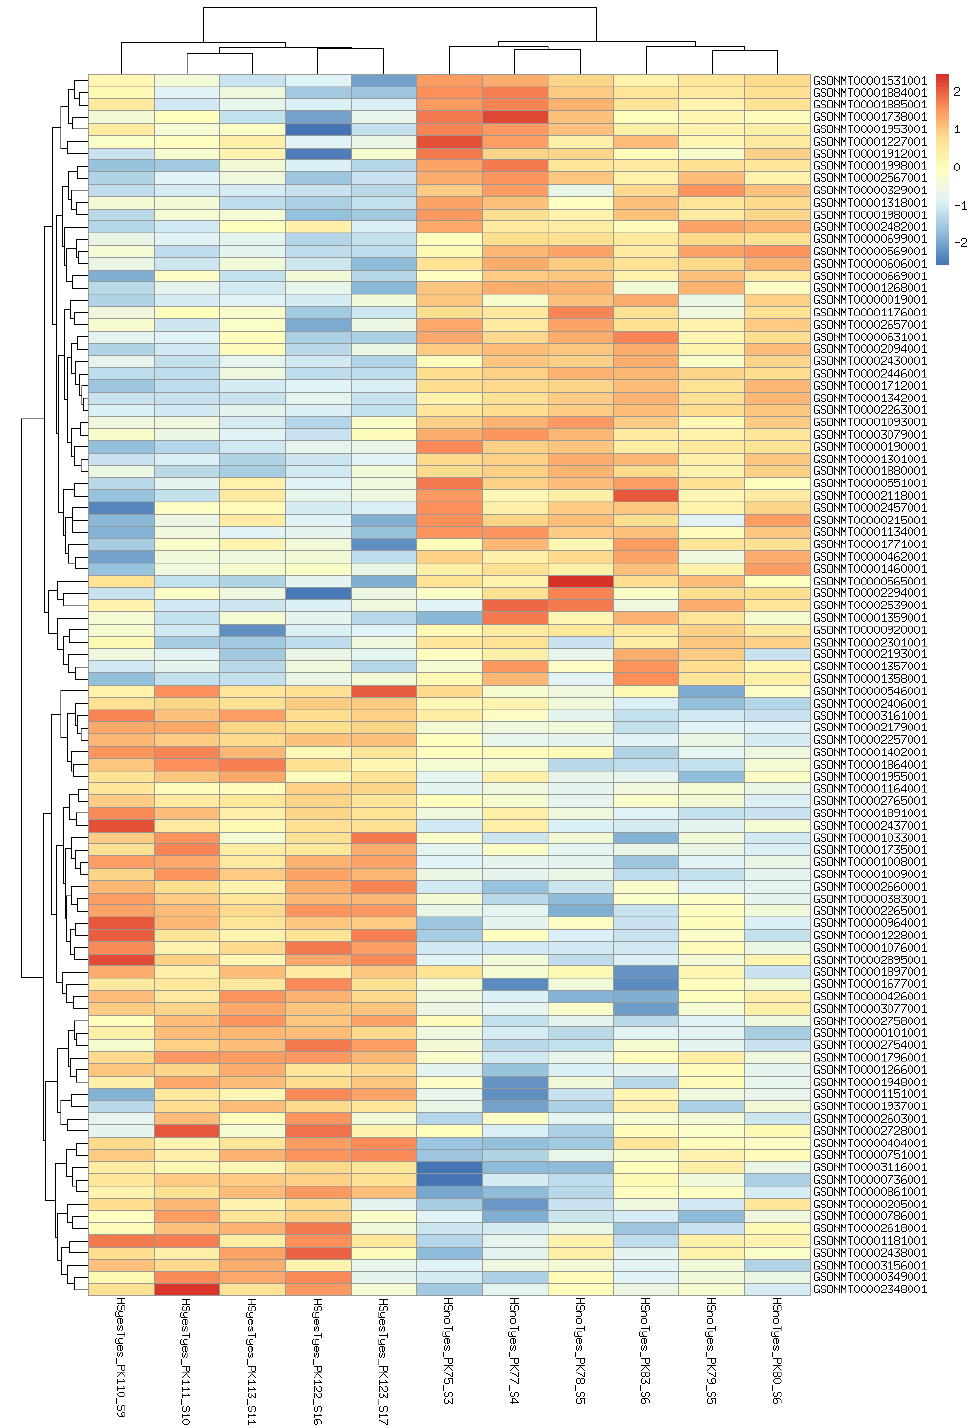
Figure 3. Heatmap of 100 most significant differentially expressed genes affected by increased temperature in taxifolin − treated fishes.